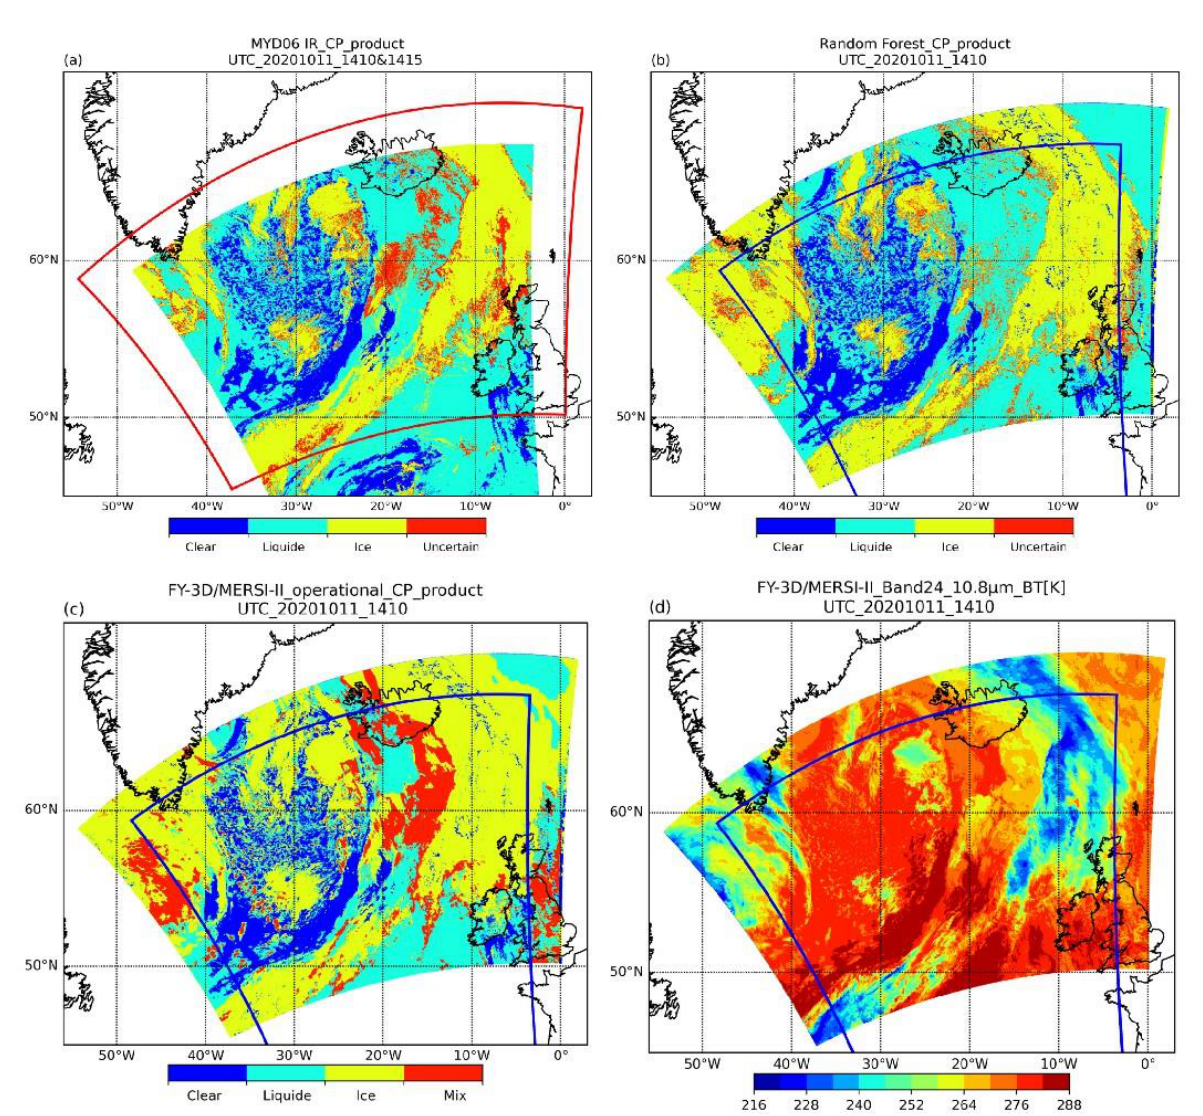
Figure 4. Comparisons of CP phase on 11 October 2020, in mid-latitude spring and autumn for ( a ) the MODIS CP product at 14:10 and 14:15 UTC, ( b ) the RF CP product at 14:10 UTC, ( c ) the operational FY-3D/MERSI-II CP product at 14:10 UTC, and ( d ) the FY-3D/MERSI-II band-24 BT at 14:10 UTC. The red box is the outline of the 14:10 UTC FY-3D image, and the blue box is the contour of the 14:10 and 14:15 UTC Aqua images.